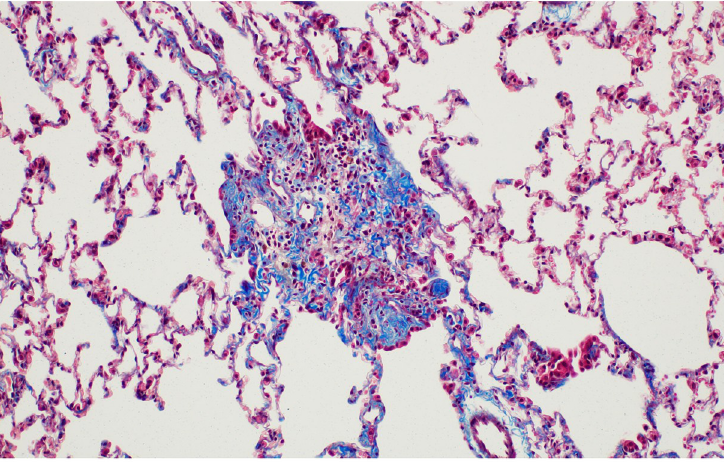
Fig 9. The histologic findings of lung fibrosis at 26 weeks after PHMG exposure. Fibrotic mass-like lesion of alveolar septa is shown (Ashcroft score 4) (MT stain,